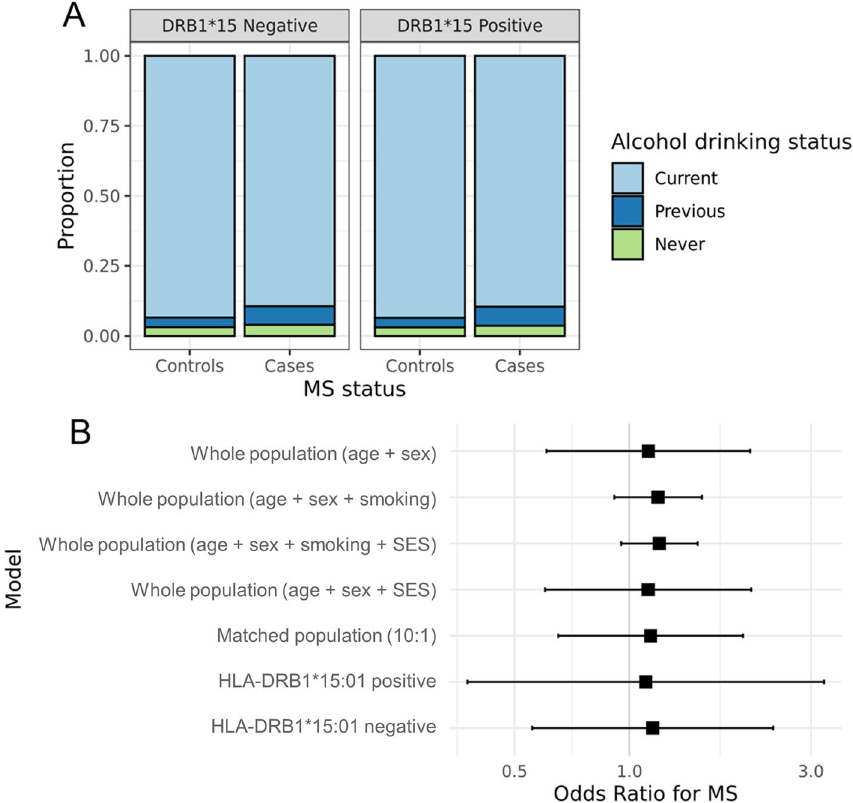
Figure 1. ( A )—Alcohol drinker status for people with MS and controls in UK Biobank, divided by DRB1*15:01 negative and positive individuals. The proportion of ‘never-drinkers’ was similar between the MS and control groups. ( B )—Forest plot depicting odds ratios for MS given lifelong abstinence from alcohol in UKB. Each point represents the OR from a multivariable logistic regression model with its 95% confidence interval. Note that the x axis is on the log10 scale. Each estimate is derived from a different model, with a variety of sensitivity analyses shown. These analyses include use of different confounding covariates, a matched nested case–control population, and a stratified analysis (by HLA-DRB1*15:01